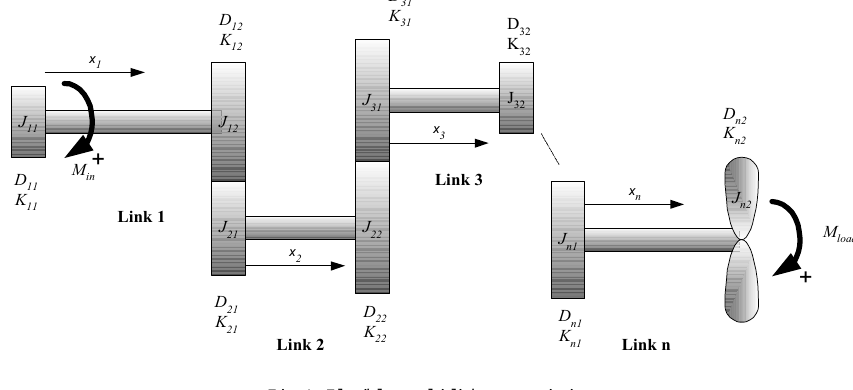
Fig. 1. Flexible, multi-link, transmission.